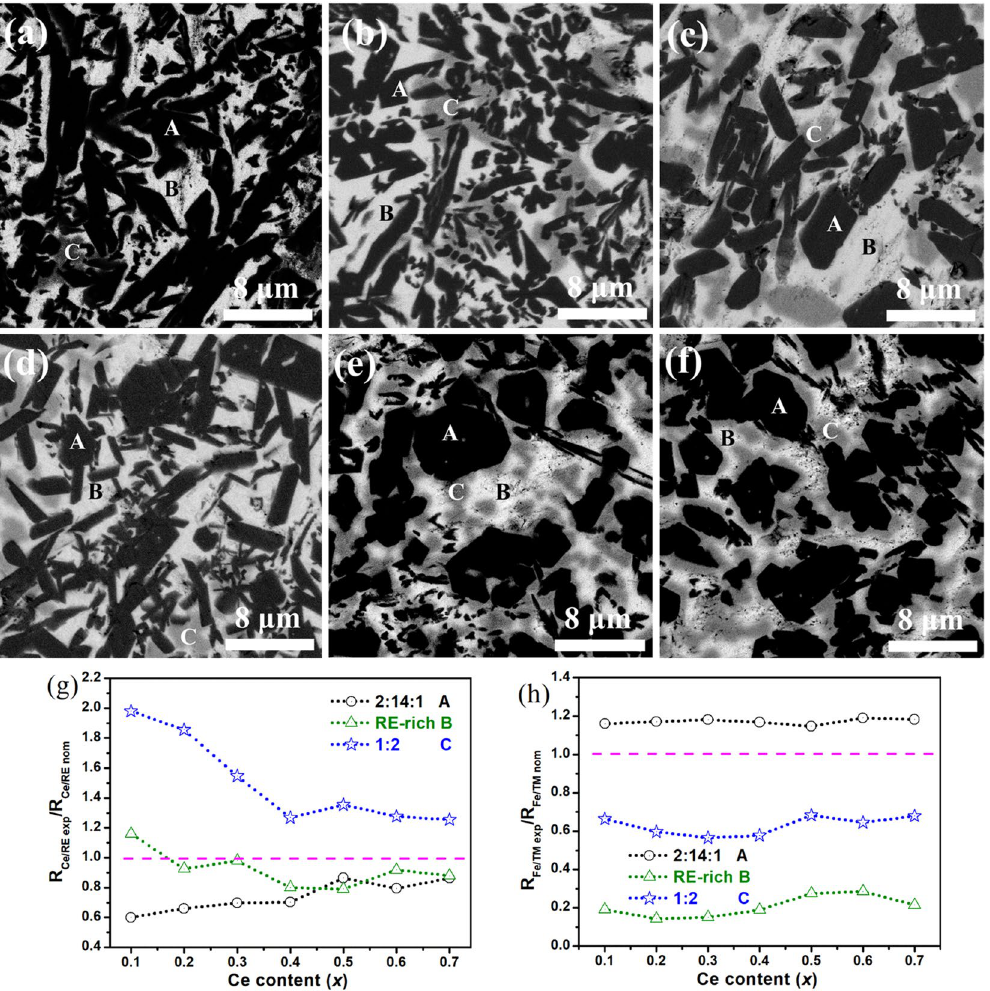
Figure 2. Back-scattered SEM images for the as-cast (Nd 1 − x Ce x ) 25 Fe 40 Co 20 Al 4 B 11 alloys with ( a ) x = 0, ( b ) x = 0.2, ( c ) x = 0.3, ( d ) x = 0.4, ( e ) x = 0.5, and ( f ) x = 0.7, and the dependences of R Ce/RE exp /R Ce/RE nom ( g ) and R Fe/TM exp /R Fe/TM nom ( h ) ratios on Ce content x for different